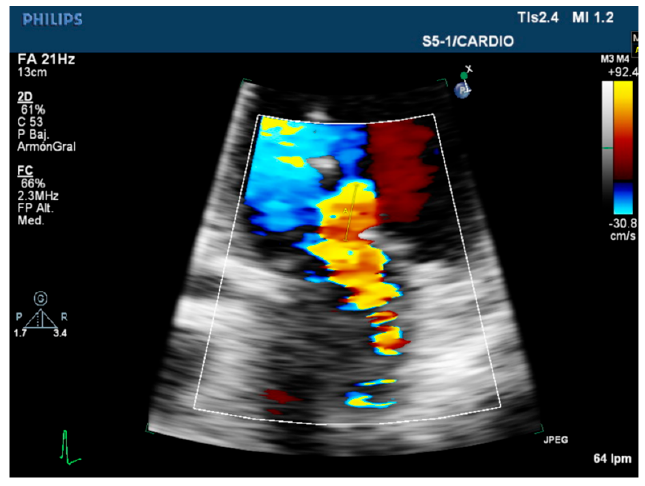
Figure 2. Transthoracic echocardiography. PISA measurement in severe mitral regurgitation.